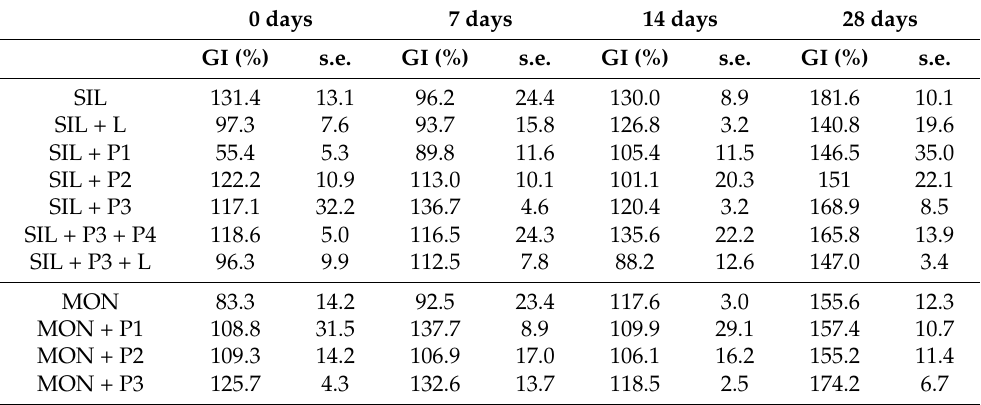
Figure 2. Bioluminescence inhibition (%) of Vibrio fischeri at 30 min. of exposure to elutriates from ( A ) SIL and ( B ) MON mesocosms (conditioned with P1,2,3,4 and P3 + P4) at the various experimental times (0, 7, 14 and 28 days). The vertical bars are the standard errors. SIL: a sandy-silty-clay soil; MON: gravel in a sandy-silty soil. P1, P2, P3, P4: foaming agent products; L: lime. The results of the L. sativum germination tests, expressed as the Germination index (GI%), are reported in Table 4. In all conditions, except for SIL + P1 at 0 days, no significant effect on the GI values was observed (values > 80%) and in several cases, a positive effect was even recorded. Table 4. Lepidium sativum Germination index (GI%) ± standard errors (s.e.) obtained from elutriates of the various P-conditioned or non-conditioned (SIL or MON) soil mesocosms at different experimental times (0, 7, 14 and 28 days). SIL: sandy-silty-clay soil; MON: gravel in a sandy-silty soil. P1, P2, P3, P4: foaming agent products; L: